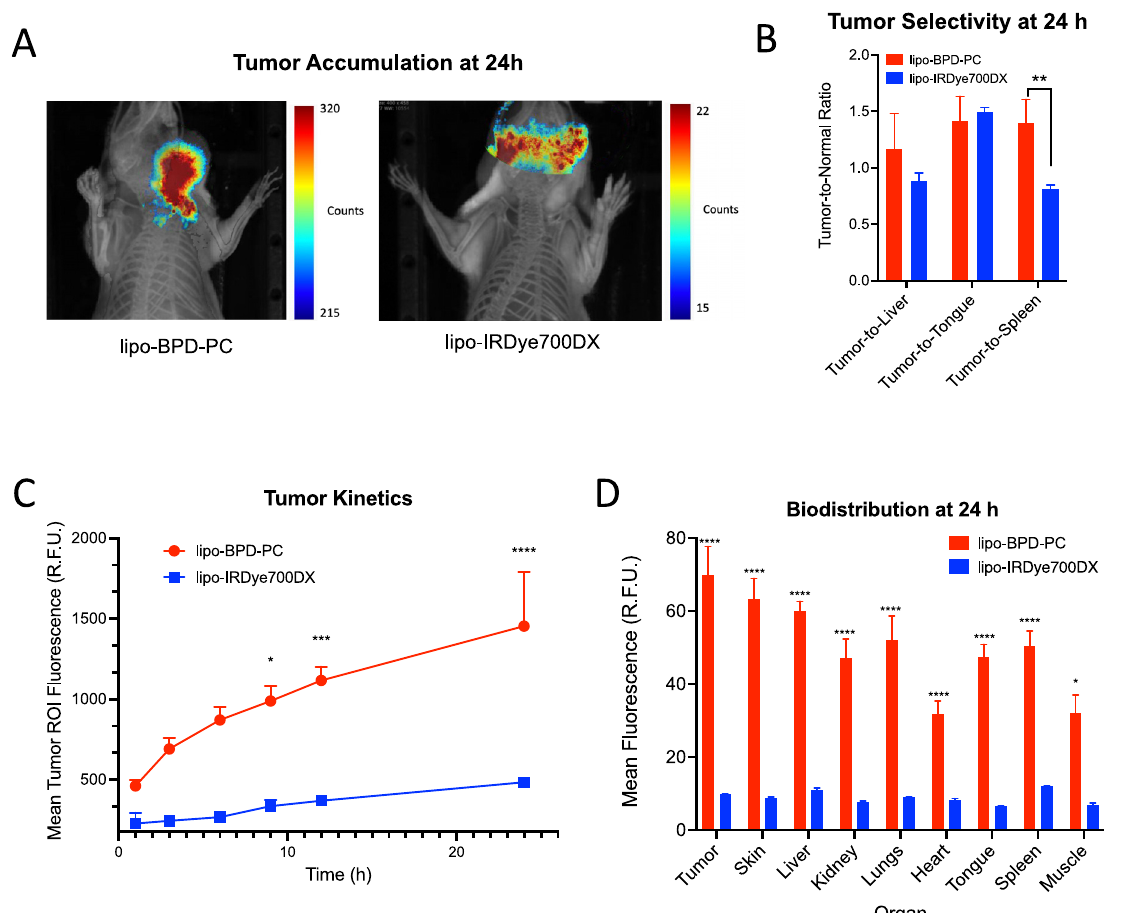
Figure 9: (A) Representative FLI/µCT images of orthotopic FaDu tumors 24 h following intravenous administration of lipo-BPD-PC and lipo- IRDye700DX. (B) Tumor selectivity of lipo-BPD-PC and lipo-IRDye700DX 24 h following intravenous administration. (C) Longitudinal fl uores- cence imaging of lipo-IRDye700DX and lipo-BPD-PC in orthotopic FaDu tumors to assess tumor kinetics. (D) Semi-quantitative fl uorescence- based analysis of liposome biodistribution 24 h following intravenous administration. (Data are mean ± standard error; n ≥ 4 mice per arm; statisticalsigni fi cancewascalculatedusingone-wayANOVAwithaTukeypost-test,*: P ≤ 0.0.5,**: P ≤ 0.005,***: P ≤ 0.0005,****: P ≤ 0.0001).